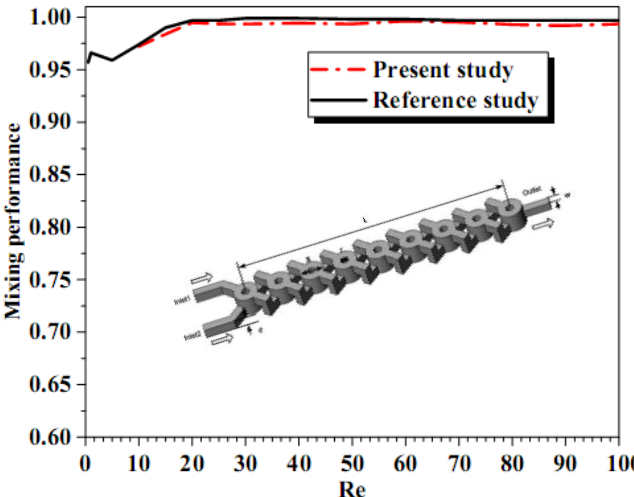
Figure 6. Evolution of mixing rates Vs Reynolds number with Jibo et al. [44].